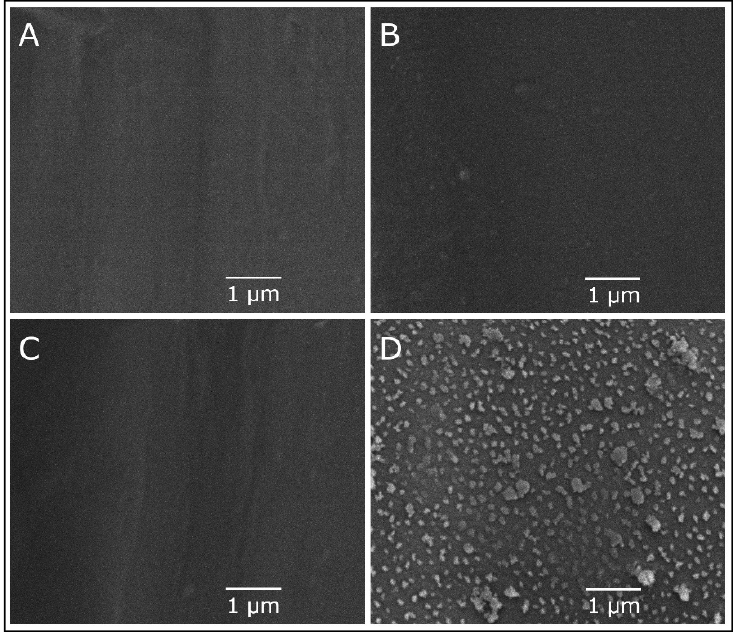
Figure 6. SEM image of the top surface of a PES membrane ( A ), PES/PDA membrane ( B ), PES/PDA/MPC membrane ( C ), and PES/PDA/MPC/CuO membrane ( D ) at 20,000× magnification. membrane ( C ), and PES/PDA/MPC/CuO membrane ( D ) at 20,000 × magnification.